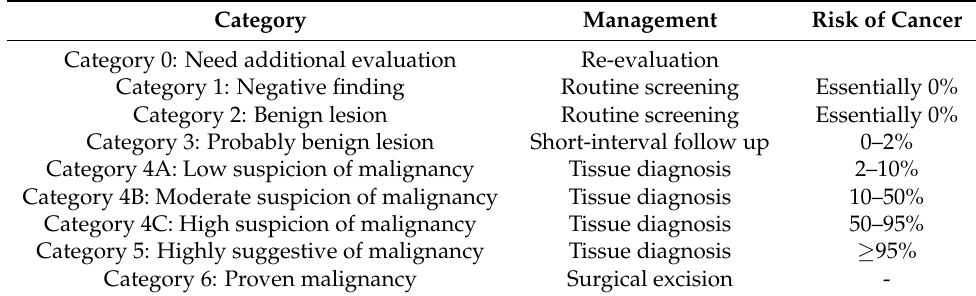
Table 1. BI-RADS mammographic assessment